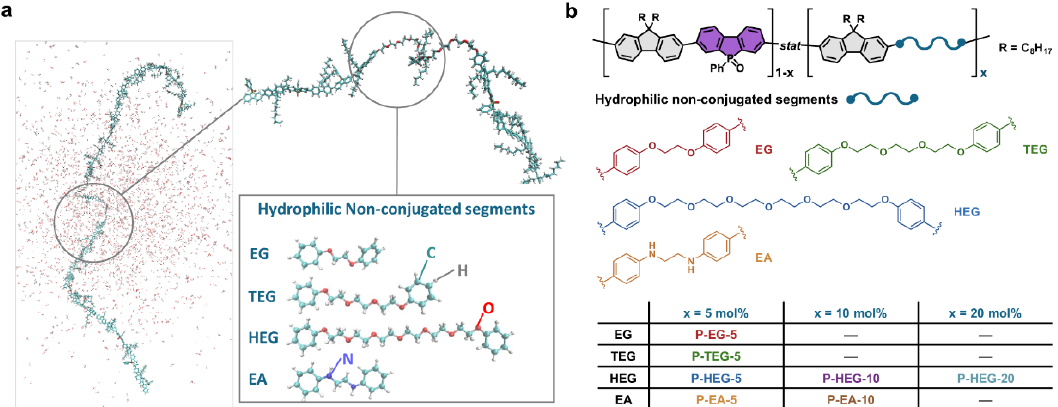
Figure 14. ( a ) Schematic illustration of the polymer photocatalysts containing hydrophilic non-conjugated segments; ( b ) Structures of hydrophilic segments and polymer repeat units [Figure adapted from ref. [100] under CC-BY 4.0 License].